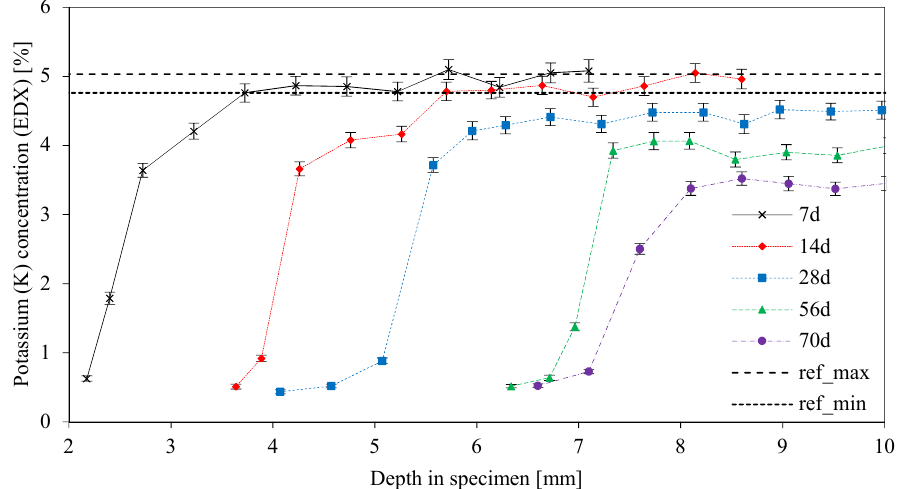
Figure 12. MK54 potassium concentration from EDX elemental mapping, as a function of depth in the specimen. Curves for different exposure times up to 70 days and reference lines ref min and ref max from the original unexposed geopolymer sample.